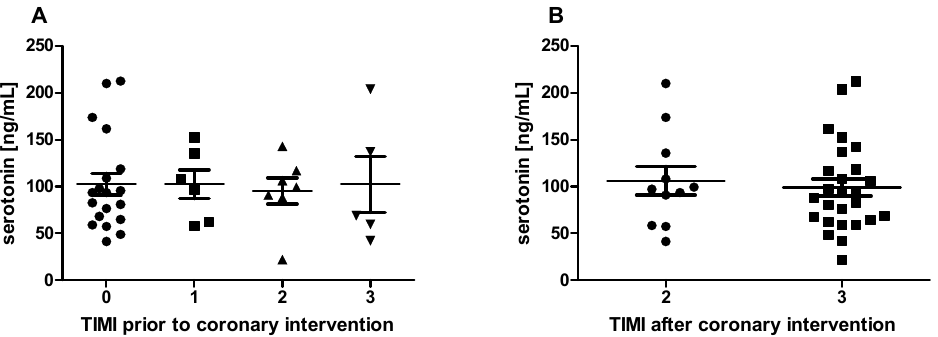
Figure 2. Serum serotonin levels according to a visual analysis of coronary angiography using the thrombolysis in myocardial infarction (TIMI) grade; TIMI prior to coronary intervention ( A ) and after coronary intervention ( B ).